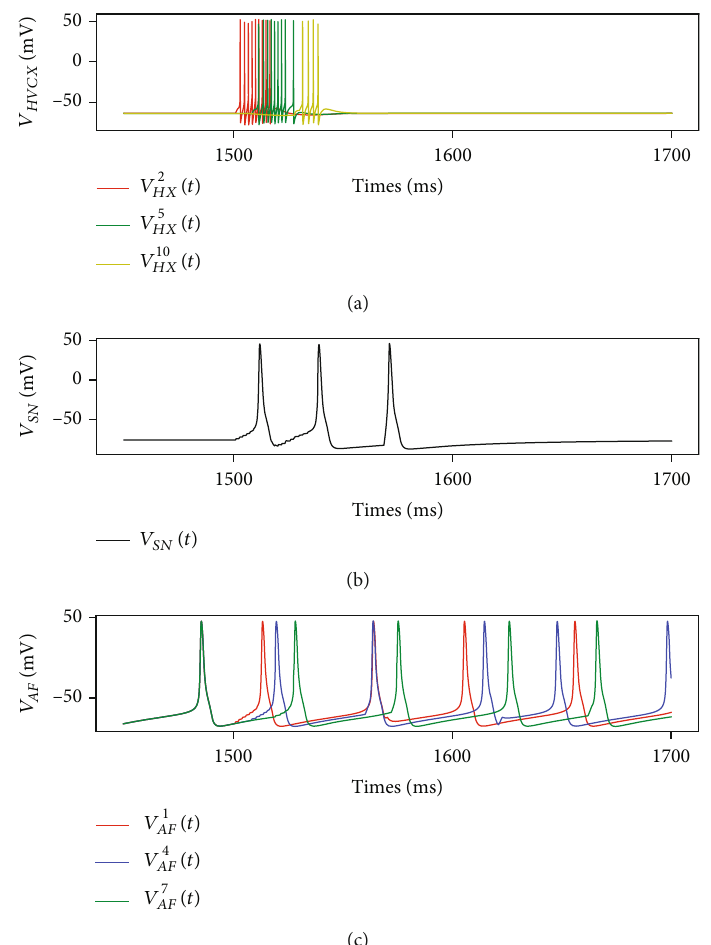
Figure 6: Membrane voltages of neurons in HVC and Area X. Before the song, HVC state while AF neurons oscillate at about 20 Hz (c). At 1.5s, the fi rst HVC